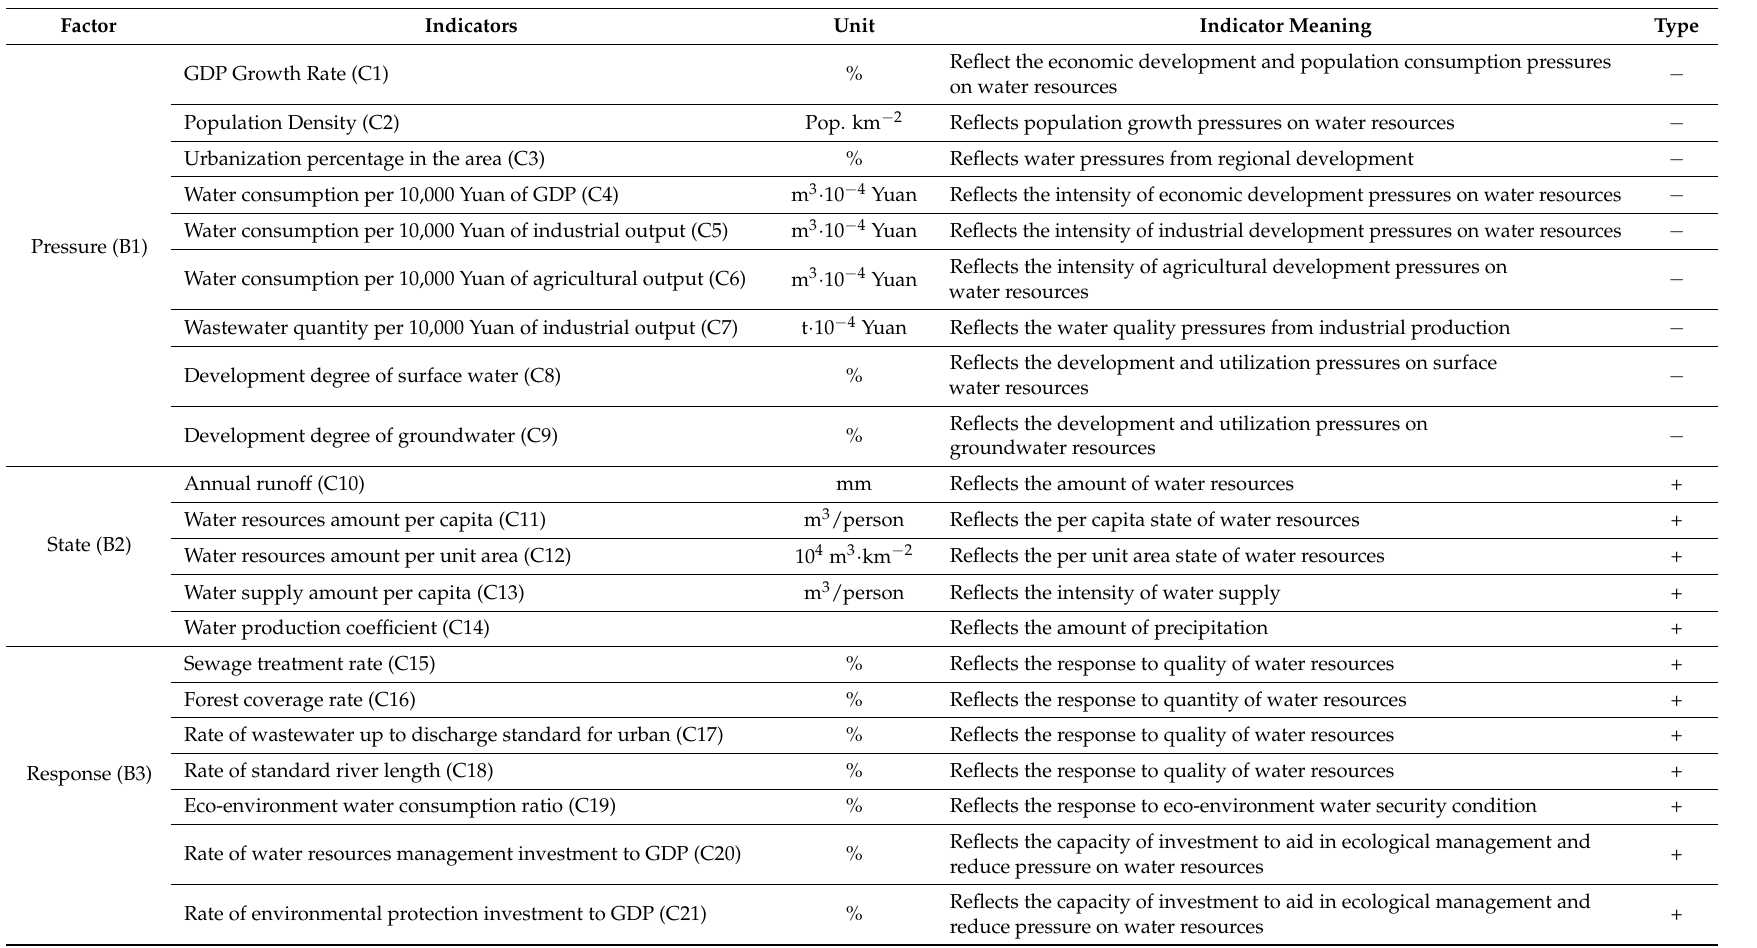
Table 1. Evaluation index system of water resource